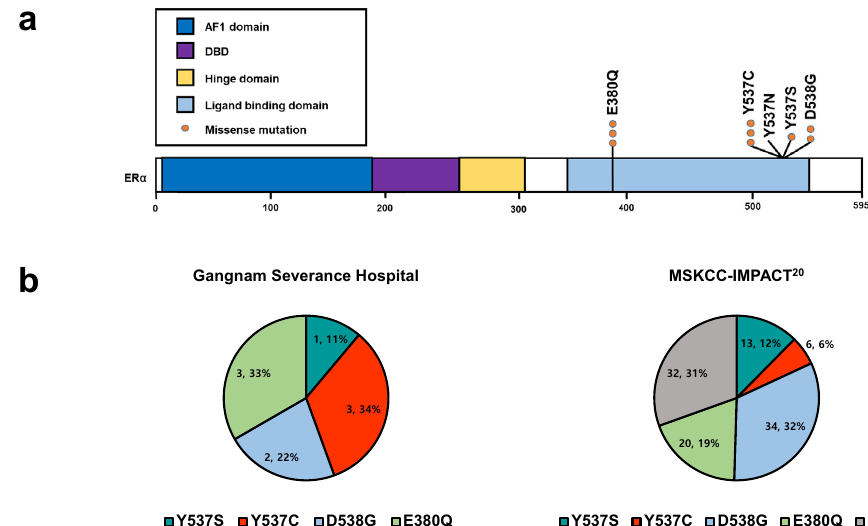
Fig. 2 ESR1 missense mutation in nine patients. a Locations and frequencies. b Distributions of ESR1 missense mutation sites: comparison the Gangnam Severance Hospital with the MSKCC-IMPACT series 20